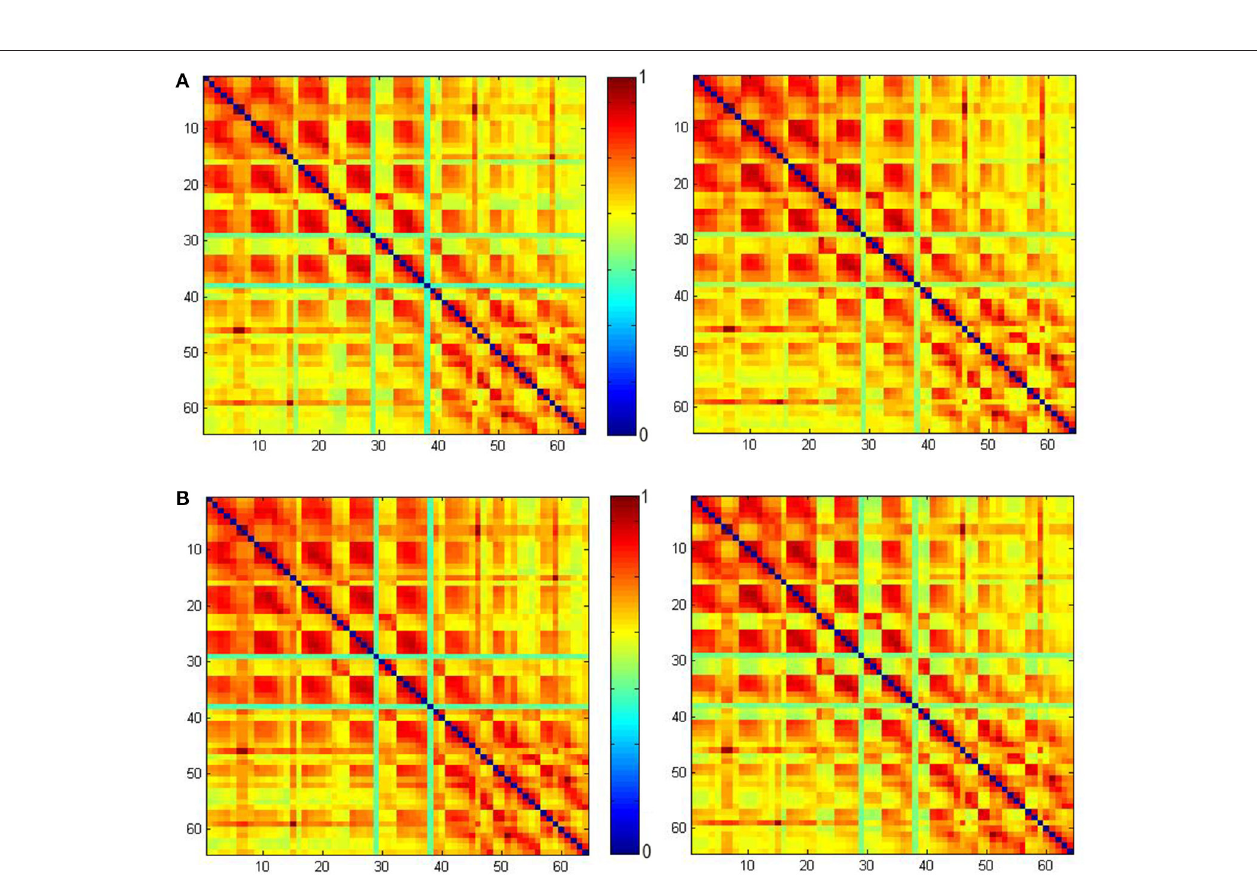
FIGURE 8 | The phase-locking values (PLVs) obtained using the method given in Lachaux et al. (1999) calculated from our ECoG data from 2.4 to 3s (left) and 3 to 3.6s (right) filtered by the 8–20Hz band. PLV for CS